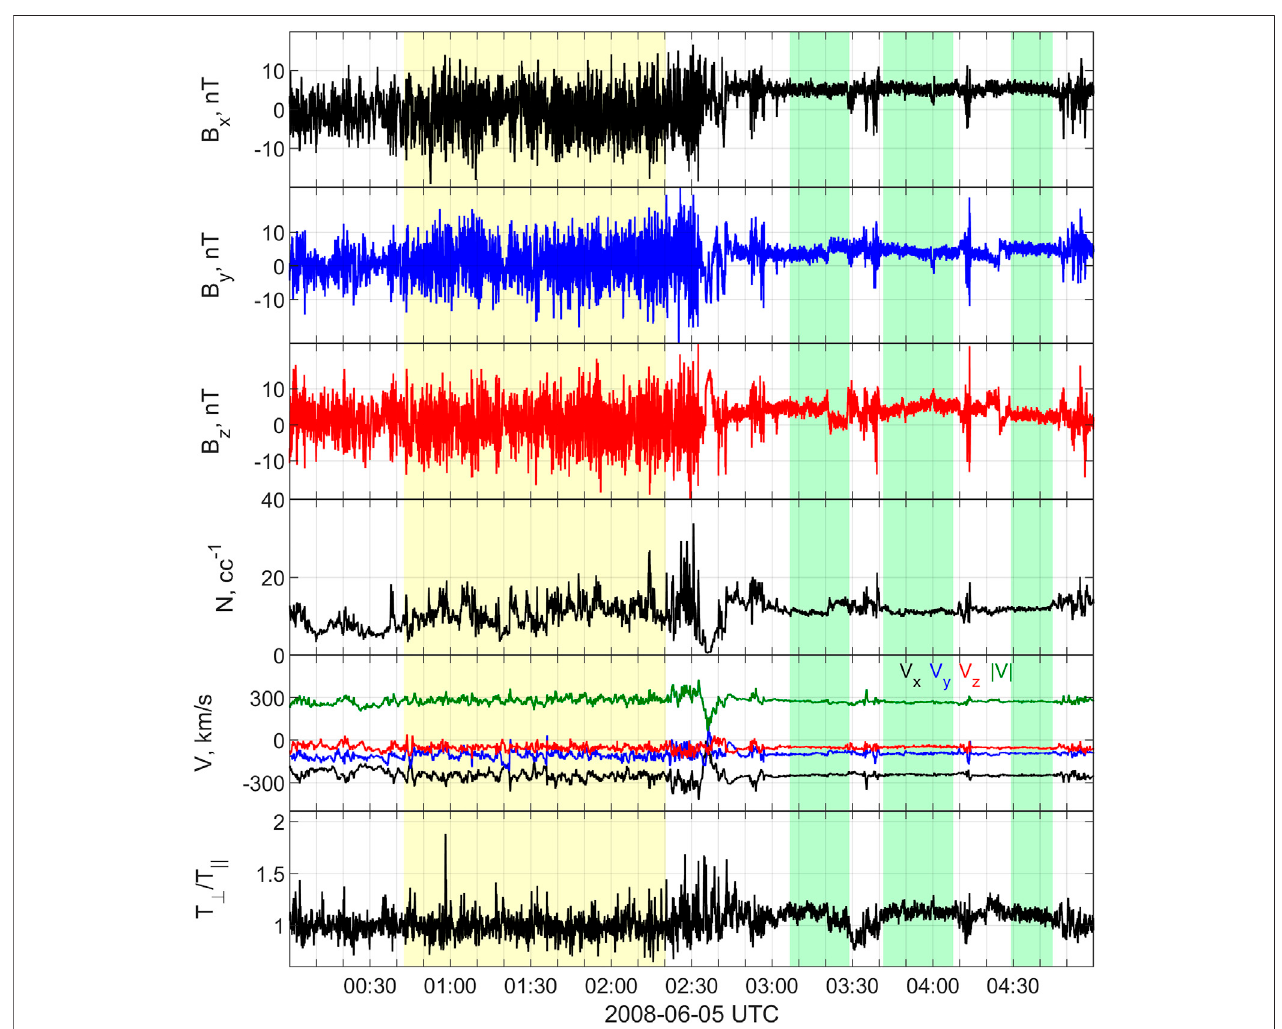
FIGURE 1 | Overview of the event on 5 June 2008, 00:00 – 05:00 UTC observed by Cluster 3. From top to bottom: three components of the magnetic fi eld; ion density; ion velocity components and magnitude; temperature anisotropy. The vectors are in GSE coordinate frame. The shaded areas indicate the sub-samples in the quasi-parallel (yellow) and quasi-perpendicular (green)